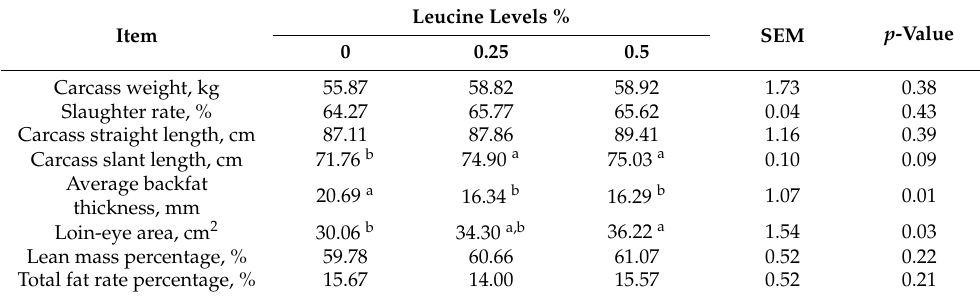
Table 4. Carcass trait of finishing pigs fed the diets with various levels of leucine.